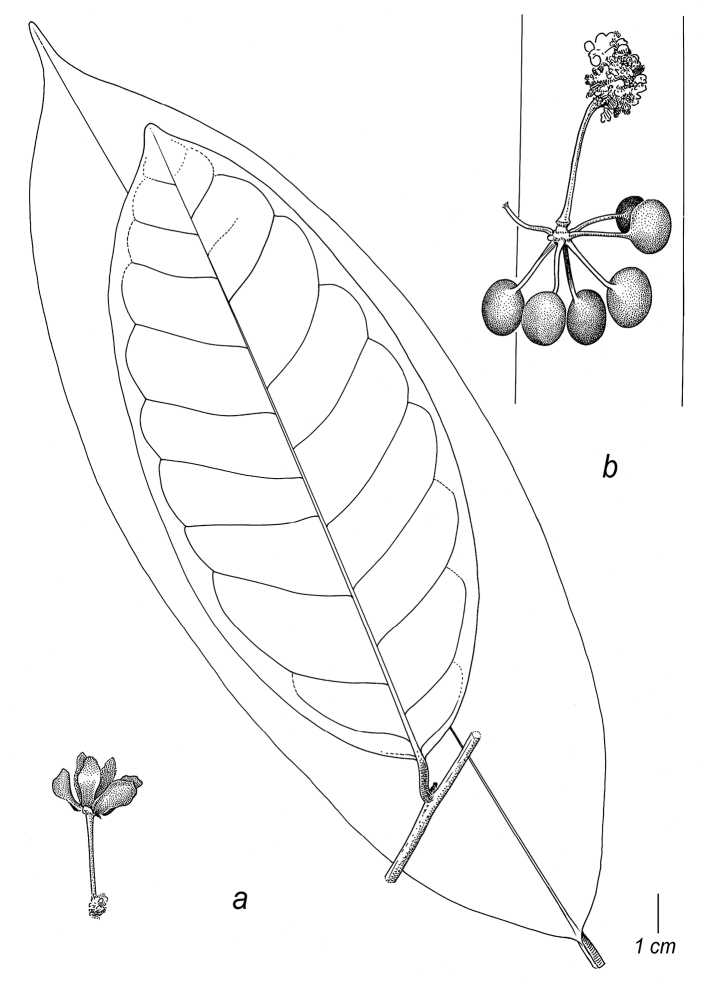
Cremastospermaantioquense Pirie. a leaf and flower b fruit (aSoejarto 2798bSoejarto 3586).